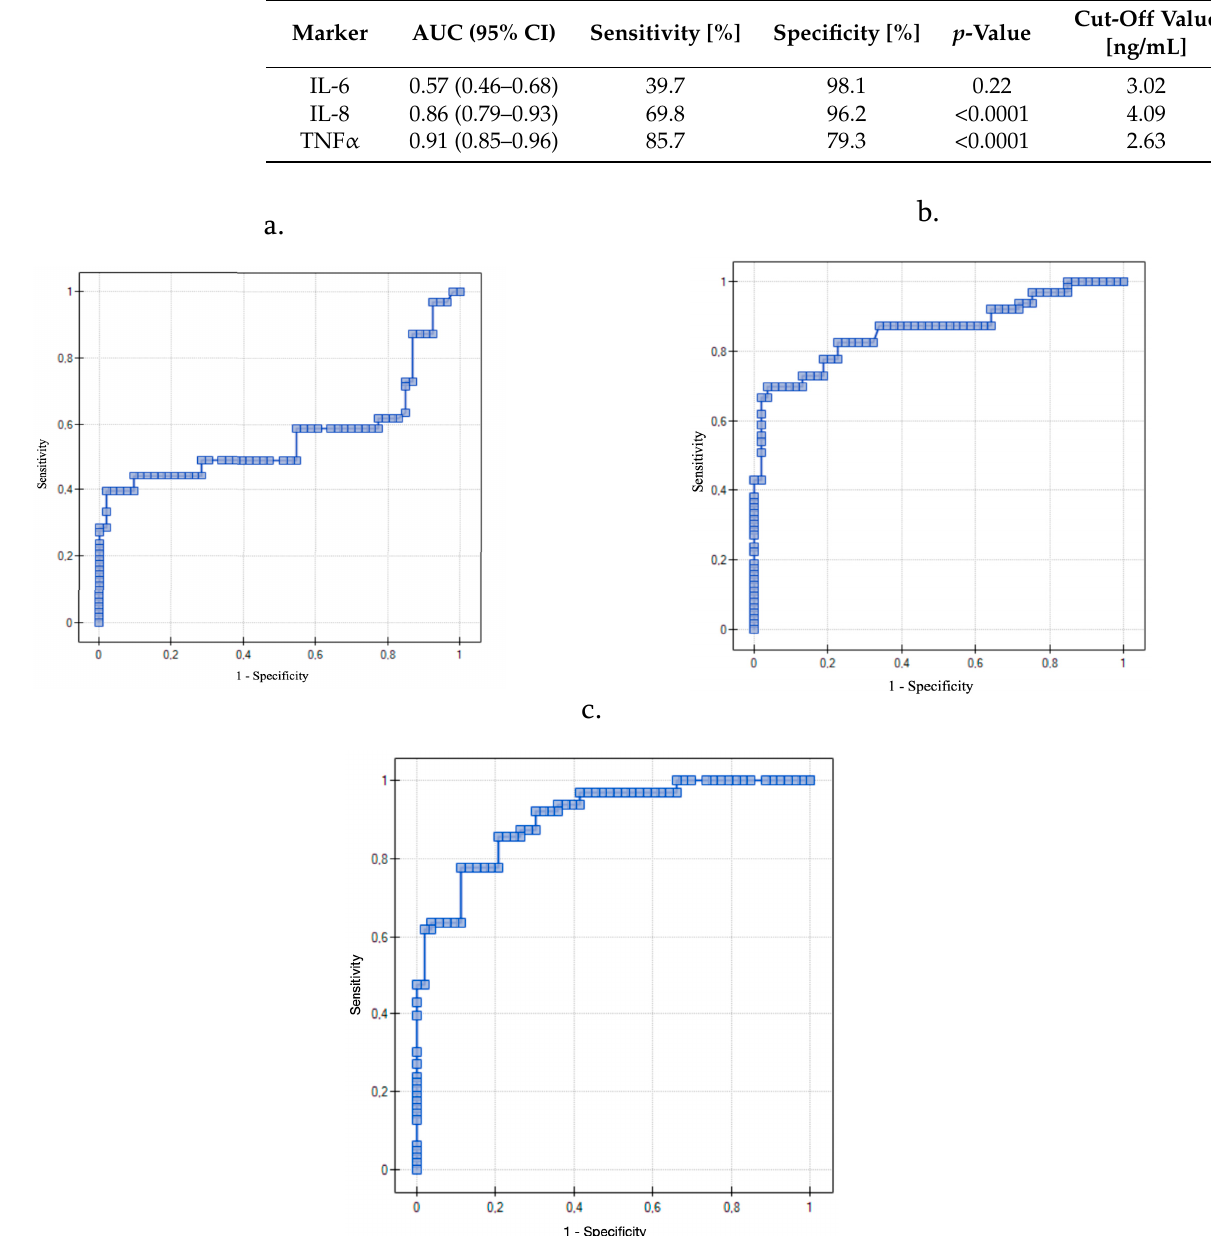
Figure 1. Receiver operating characteristic curve for using ( a ) IL-6 ( b ) IL-8, and ( c ) TNF- α in distinguishing between ovarian carcinoma and benign ovarian cystic lesions.